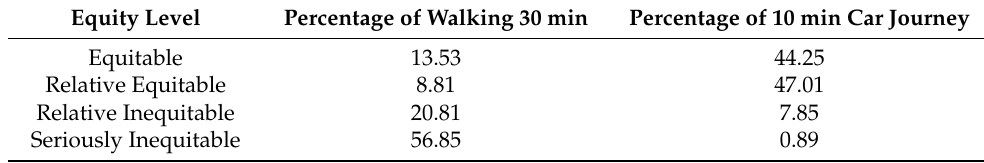
Table 7. Equity level statistics for overall area with walking 30 min and driving 10 min by